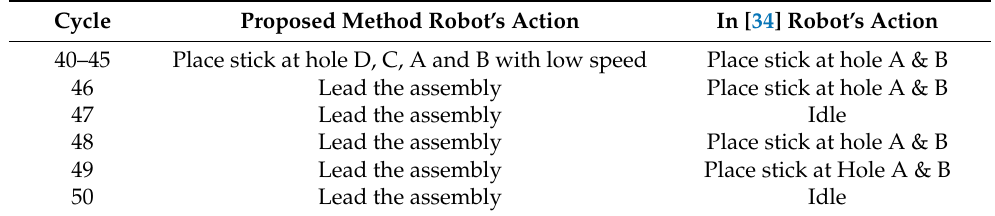
Table 13. Adaptation Ability